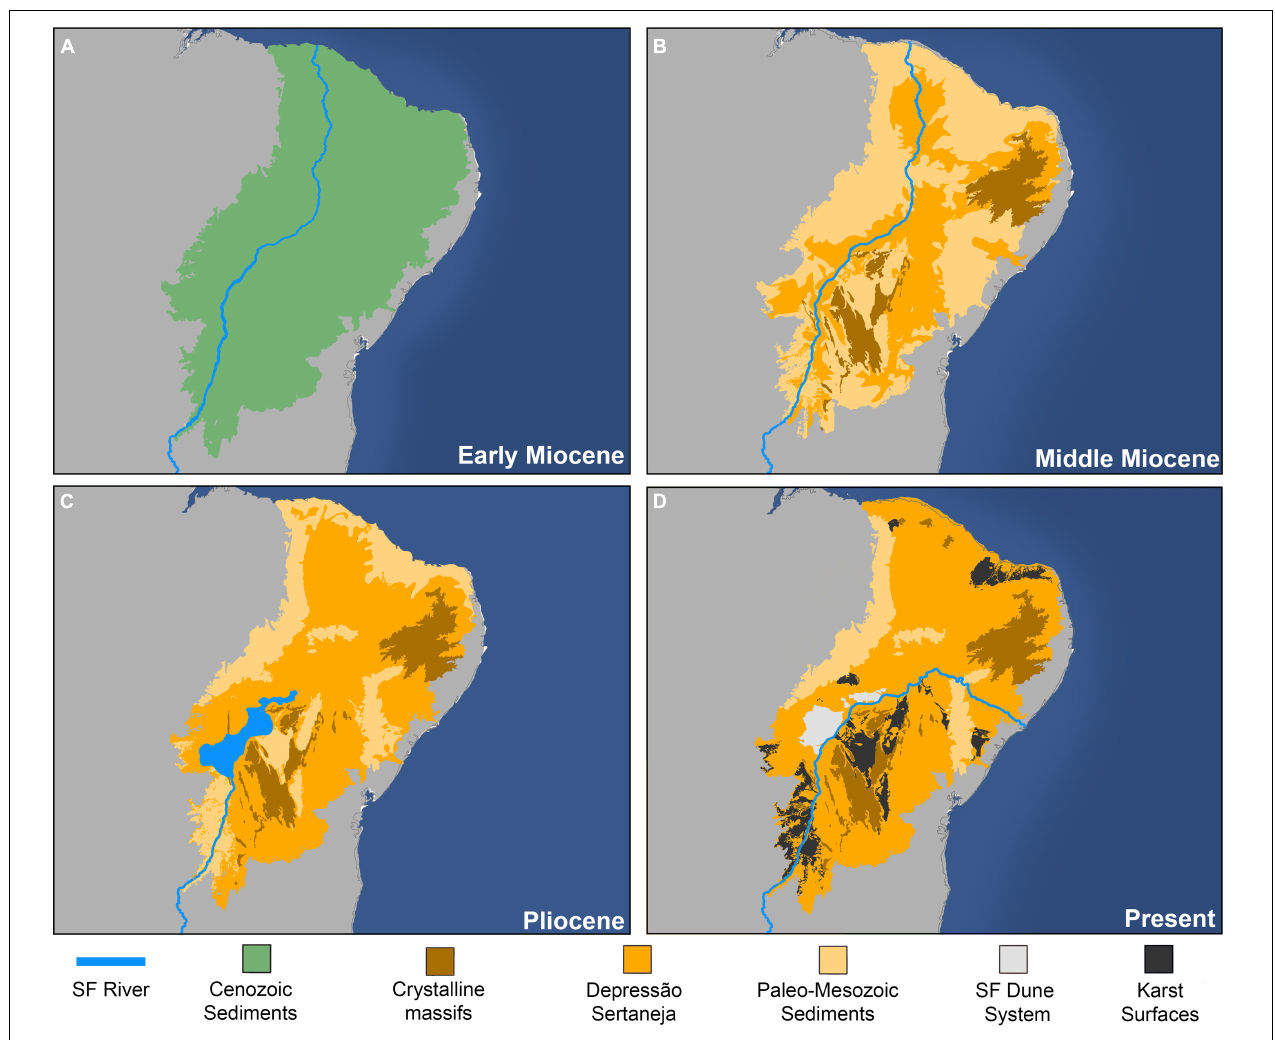
FIGURE 2 | Paleogeographic maps of the transition from the widespread paleo-sedimentary surface to modern heterogeneous Caatinga landscapes. (A) The sedimentary cover accumulated during previous times is maintained in the Caatinga due to the widespread dominance of tropical rainforests over the region at Early Cenozoic (Fine and Ree, 2006; Jaramillo and Cardenas, 2012). (B) Global climate changes and increased uplift and erosion at the Miocene (Rodríguez-Tribaldos et al., 2017; Klöckinga et al., 2020) exposed the Paleo-Mesozoic sediments accumulated due to post-rift sedimentation–after fragmentation of Gondwana supercontinent (Magnavita et al., 1994; Maia et al., 2010; Bezerra et al., 2011; Gurgel et al., 2013) and generated a new, low-level peneplain, known as Depressão Sertaneja. (C) Pliocene tectonic reactivation within the Araripe Plateau changed the course of São Francisco (SF) River, which had a paleo-course flowing toward the equatorial Atlantic; this event created an endorheic drainage at the central region of the Caatinga (Mabesoone, 1994). (D) In the Pleistocene, the lacustrine sediments, which remained after the São Francisco River acquired its current watercourse, were remodeled by wind and formed a system of continental dunes that is currently renowned by a highly endemic biota (Rocha et al., 2004; Queiroz et al., 2017). Also at this period, most of the karst systems were also exhumed (Silva et al.,